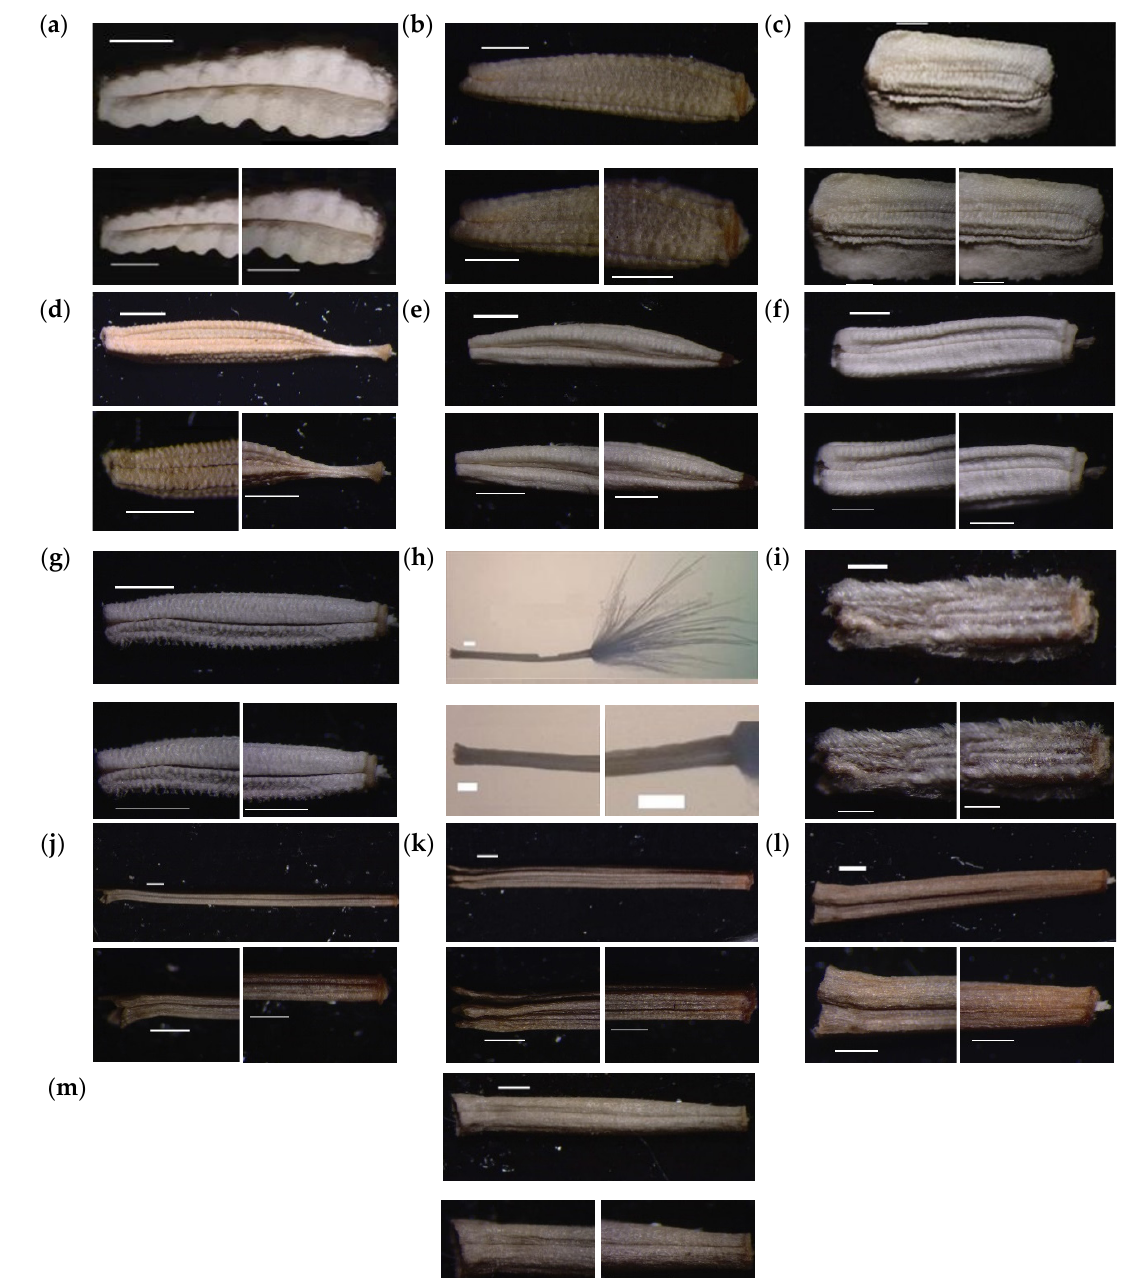
Figure 3. Stereomicrographs of inner achenes shape (upper), truncate base (lower left) and apex (lower right). ( a ) Reichardia tingitana , columnar, truncate base and apex. ( b – m ) Launaea : ( b ) L. spinosa , columnar, truncate base and apex; ( c ) L. capitata , winged-cylindrical, truncate base and apex; ( d ) L. intybacea , beaked-cylindrical, truncate base, rostrate apex; (e) L. massauensis , columnar, truncate base, cuspidate apex; ( f ) L. nudicaulis , cylindrical, truncate base and apex; ( g ) L. nudicaulis (specimen 33), columnar, truncate base and apex; ( h ) L. angustifolia subsp. angustifolia , cylindrical, horned base, truncate apex; ( i ) L. angustifolia subsp. arabica ; columnar, horned base, truncate apex; ( j , k ) L. fragilis subsp. fragilis : ( j ) cylindrical (specimens 88) or ( k ) columnar (specimens 102), horned base, truncate apex; ( l , m ) L. mucronata : ( l ) subsp. cassiniana , ( m ) subsp. mucronata , columnar, truncate base, attenuate apex. Scale bar = 0.5 mm.